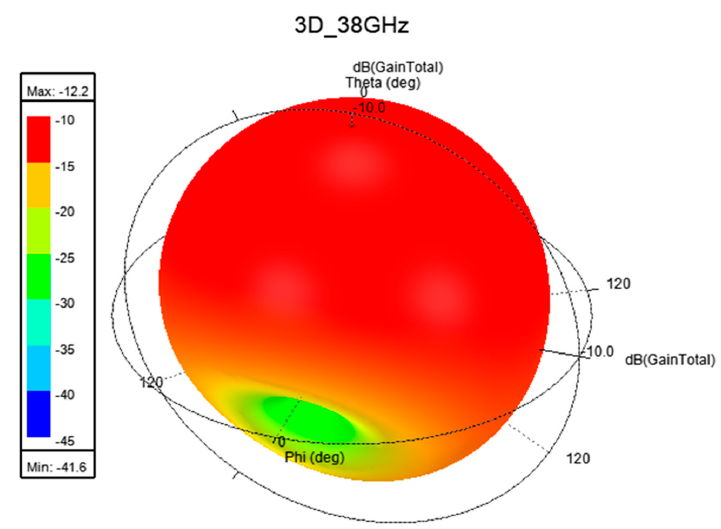
Figure 22. 2D field simulation at 38 GHz: ( a ) yz plane; ( b ) xz plane.